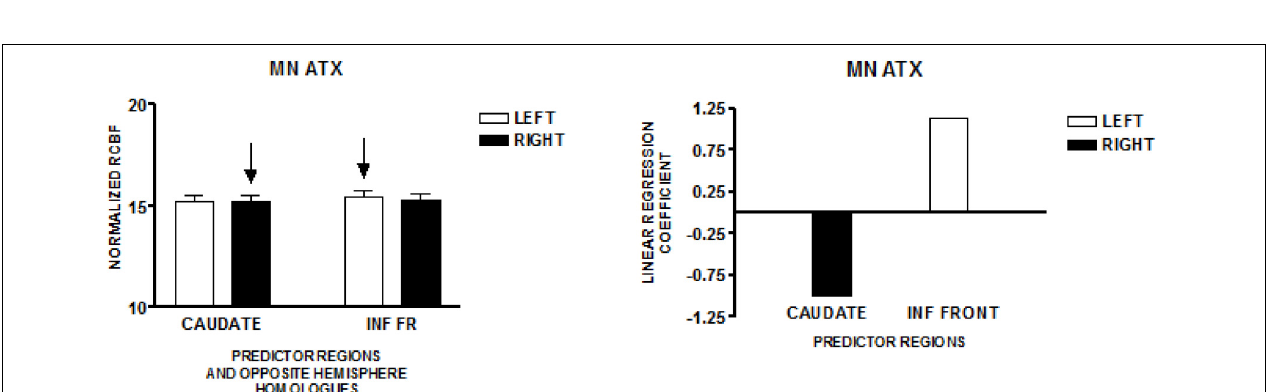
Frontiers in Neuroscience |